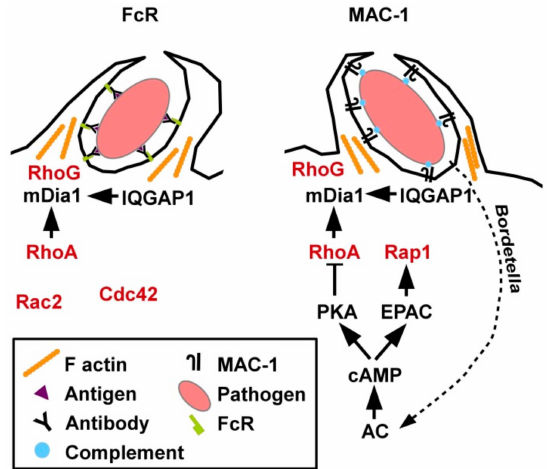
Figure 4. Phagocytic uptake of pathogens by MAC requires activity of RhoA and other small GTPases. Phagocytosis of opsonized pathogens is conferred by FcR recognizing the constant Fc part of antibodies which bind pathogen-specific surface antigens or by MAC-1 which binds activated complement deposited on the pathogen surface. In both cases partially overlapping sets of small GTPases are involved in phagocytic activity. As an evasion mechanism Bordetella bacteria generate toxins that trigger AC activity which inhibits